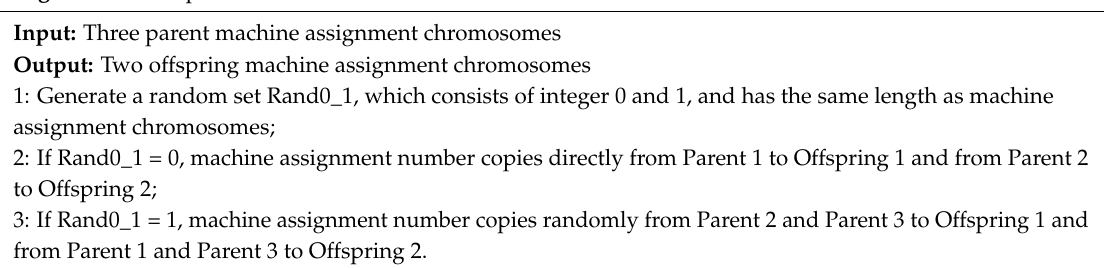
Algorithm 2 The procedure of MMPX